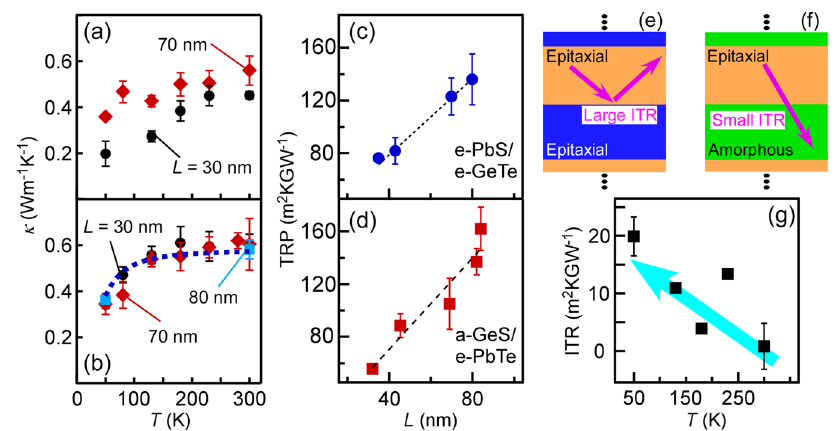
Fig. 3 Thermal transport properties of superlattices. Temperature ( T ) dependences of thermal conductivity ( κ ) values a in e-PbS/e-GeTe superlattices (SLs) with period thicknesses ( L s) of 30 and 70 nm and ( b ) in a-GeS/e-PbTe SLs with L s of 30, 70 and 80 nm (50 – 300 K). The experimental data of a- GeS/e-PbTe SL with L of 70 nm are fi tted with Eq. (2), as shown by the broken curve in b . c , d L dependences of thermal resistances per unit area of one period structure (TRP) at 300 K in c e-PbS/e-GeTe and d a-GeS/e-PbTe SLs, respectively. The dotted and broken lines are the fi tted curves of the experimental data of e-PbS/e-GeTe and a-GeS/e-PbTe SLs using Eq. (1), respectively. e , f Schematics of phonon transmission through e e-PbS/e-GeTe and f a-GeS/e-PbTe interfaces. g T dependence of interface thermal resistance per unit area (ITR) at a-GeS/e-PbTe interfaces. The error bars in a – d , g correspond to the standard deviations in the repeated